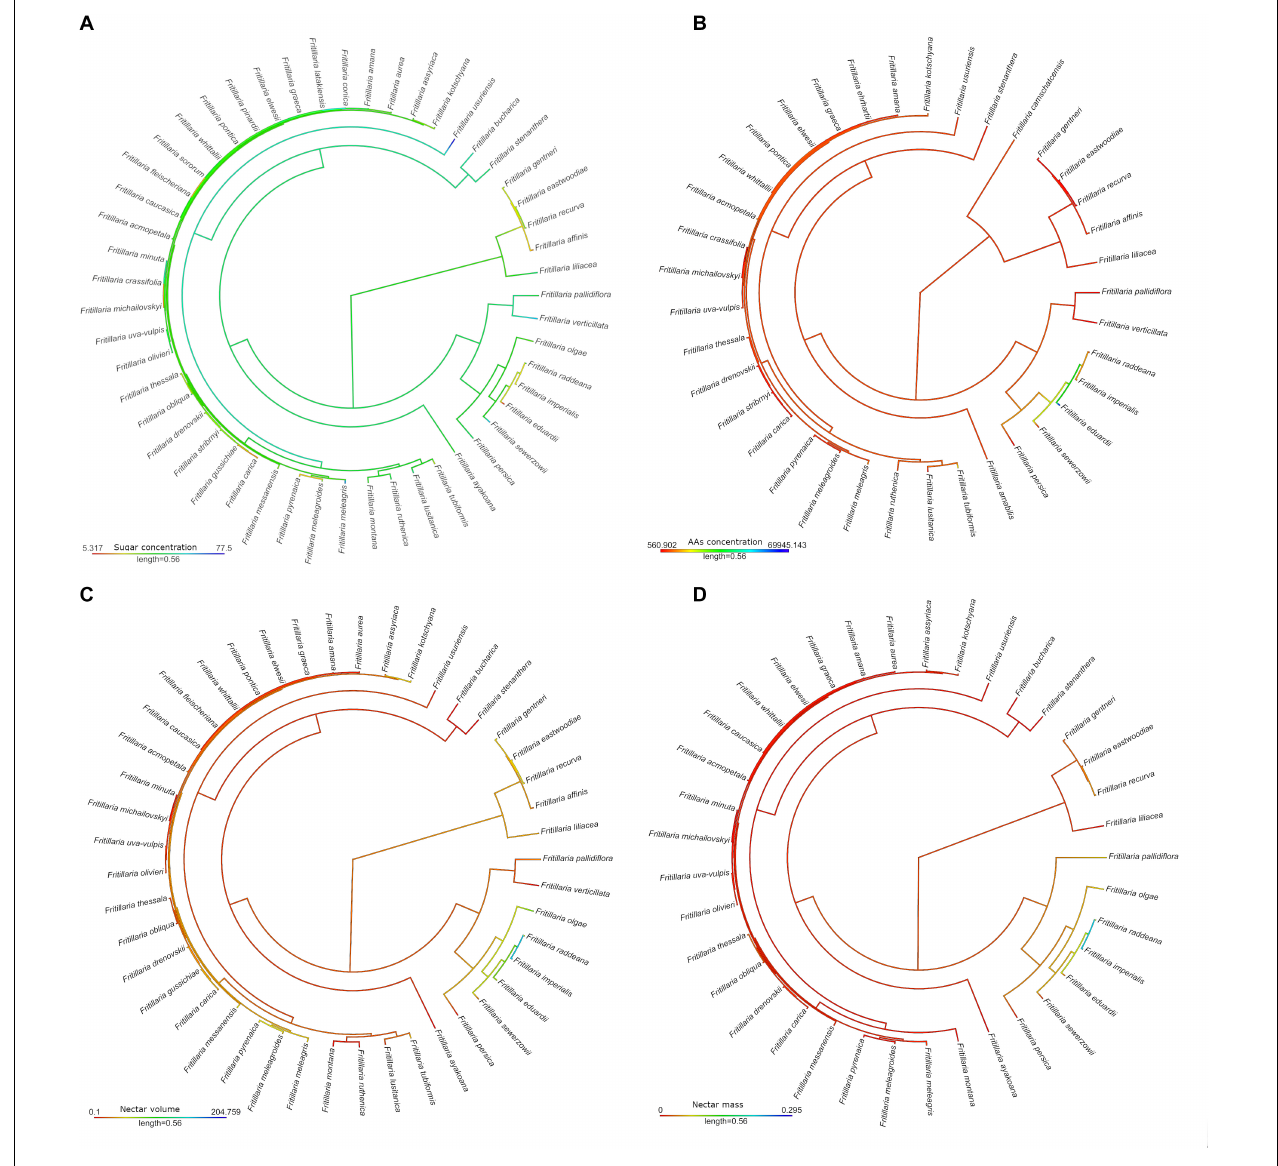
FIGURE 5 | Maximum-likelihood ancestral state reconstruction for continuous traits among studied Fritillaria species: nectar sugar (%) (A) and amino acids concertation (pmol/ µ L) (B) , nectar volume ( µ L) (C) and mass (mg) (D) . Colour intensity shows the level of presented